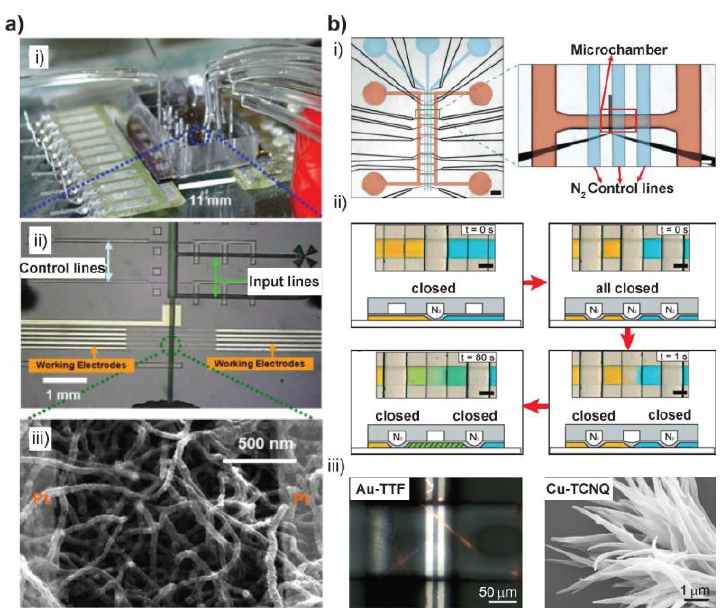
Figure 2. ( a ) Microfluidic device for the synthesis of conducting polymer NWs (CPNWs). ( i ) Actual view of the microfabricted and assembled microreactor. ( ii ) Micrograph of chip design, with microfluidic channel of 16 μm high and 100 μm wide and each of the five pairs of electrode junctions is separated by a 2-μm-wide gap. ( iii ) SEM image of well-defined polyaniline NWs grown in the microfluidic channels. ( b ) Valve-based microchamber arrays for synthesizing metal-organic 1D nanostructures. ( i ) Micrograph of the assembled chip. Black: Pt electrodes, red: fluid layer, blue: control layer. Scale bars: 750 μm (left) and 150 μm (right). ( ii ) The operation of the valves and the diffusive mixing of two food dyes (yellow and blue) in a typical reaction procedure (top and side views). Following the red arrow: supplying of two reagents when the middle valve is closed (t = 0 s); Compartmentalization of two reagent volumes on either side when all three valves closed (t = 0 s); Opening of the central valve to enable the mixing of two solutions (t = 1 s), and finally diffusive mixing (t = 80 s). Scale bars: 100 μm. ( iii ) Polarized micrograph of AuTTF wires formed inside a microchamber (left) and SEM image of Cu-TCNQ obtained from a similar valve-based microchamber device (right). Images in ( a ) are reproduced with permission from [16], ( b ) from [22].